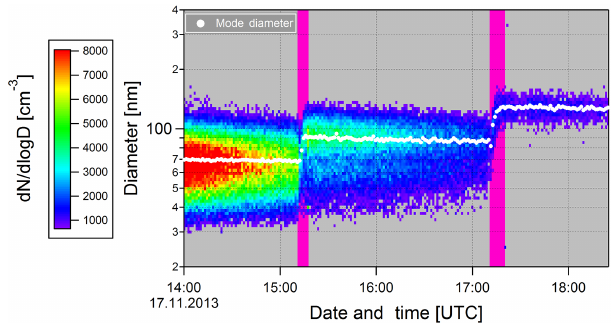
Figure 4. The aerosol size distribution measured by the SMPS at- tached to the total sampling line, for experiments performed on the 17 November 2013. The white line of points shows the mode di- ameter. Aerosol growth is clearly observed during the cloud periods (marked by the purple vertical